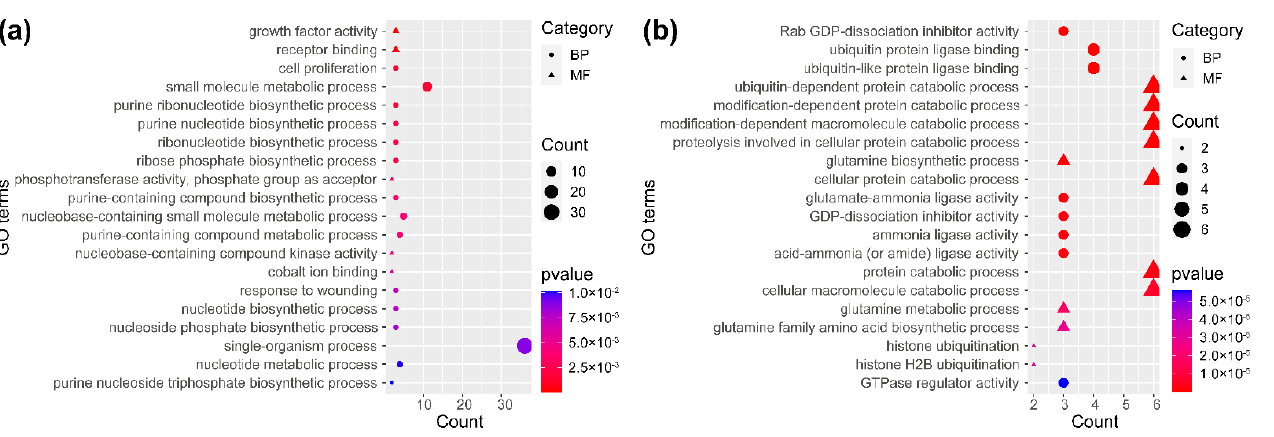
Figure 5. ( a ) Major biosynthesis pathway for cellulose, xylan, and lignin [15]. ( b ) Transcription of 79 wood biosynthetic pathway genes in groups of different traits. A redder color indicates higher gene transcription.